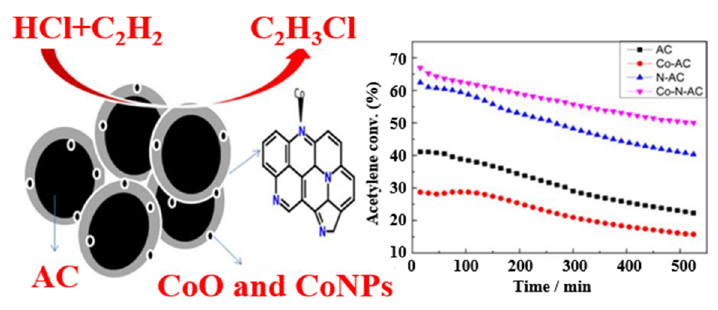
Figure 17. Co-N-AC catalyst for acetylene hydrochlorination [117].